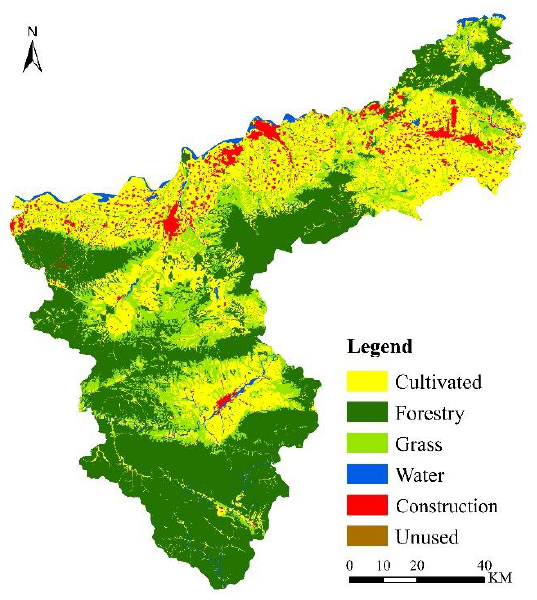
Figure 8. Land use pattern of as-is development for 2030.